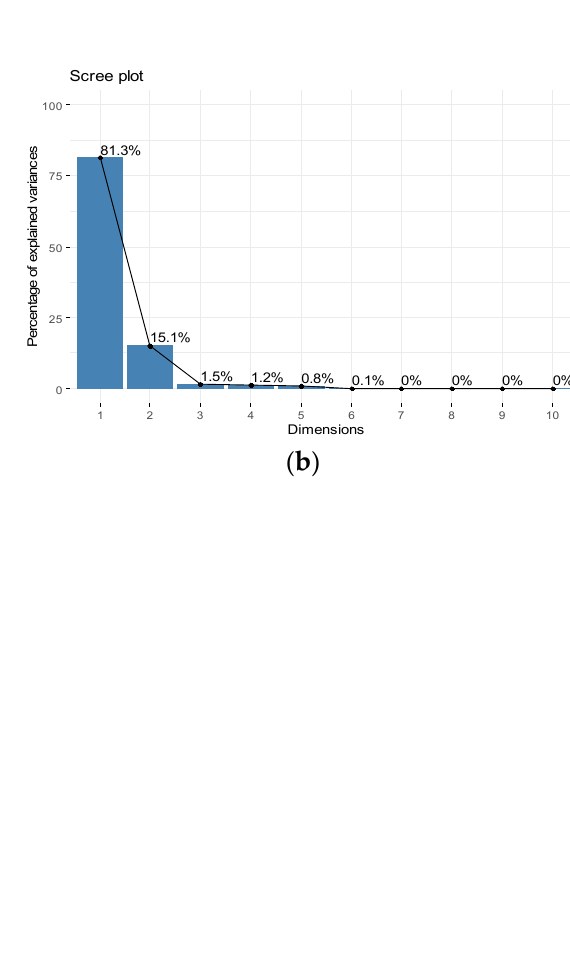
15 of 39 ( m ) Figure 7. Boxplots ( a – m ) showing Haralik texture feature comparisons of hand-annotated RTS from the Eureka Sound Lowlands and Banks Island. ( a ) H1(Angular second moment). ( b ) H2 (Contrast). ( c ) H3 (Correlation). ( d ) H4 (Variance). ( e ) H5 (Inverse difference moment). ( f ) H6 (Sum Average). ( g ) H7 (Sum Variance). ( h ) H8 (Sum Entropy). ( i ) H9 (Entropy). ( j ) H10 (Difference Variance). ( k ) H11 (Difference Entropy). ( l ) H12 (Information Measures of Correlation). ( m ) H13 (Information Measures of Correlation). Table 7. Statistical comparison of Haralik texture features of hand-annotated RTS samples from